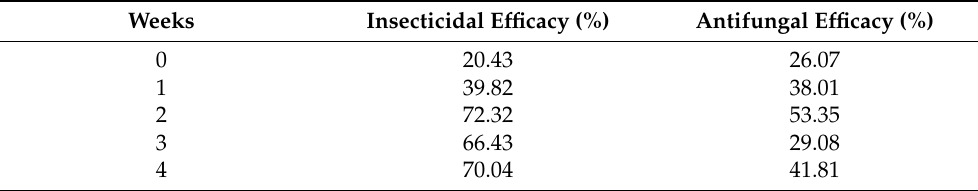
Table 4. Entomopathogenic suspension insecticidal and antifungal efficacies per